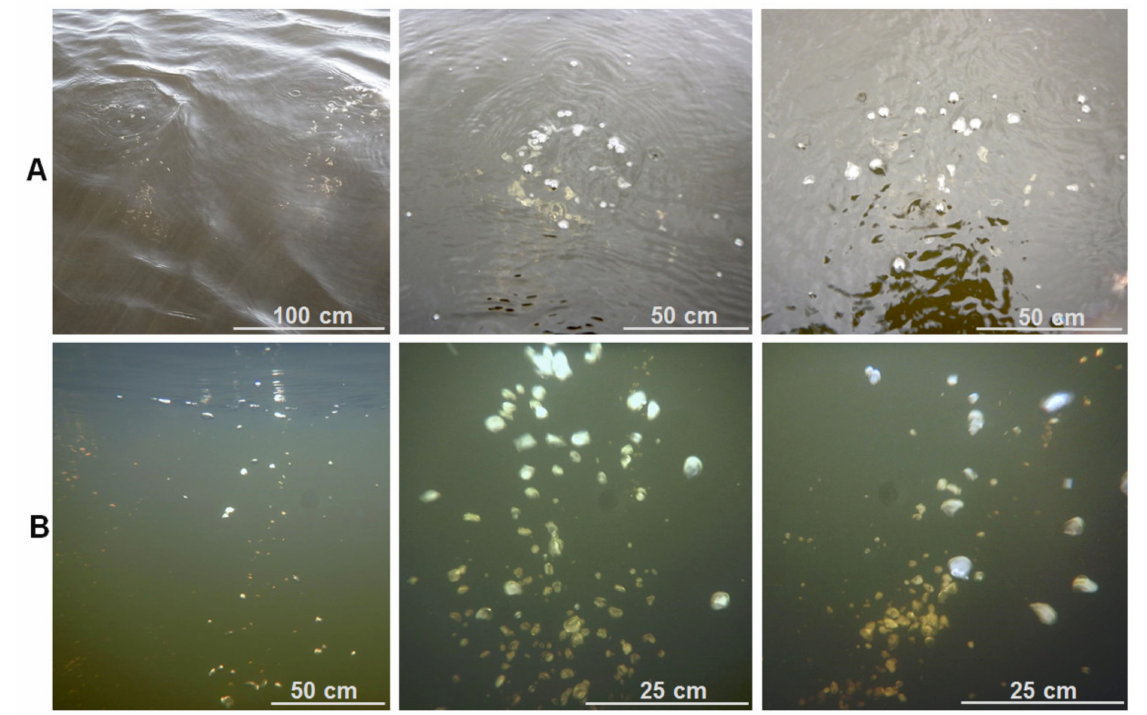
Figure 7. Typical examples of gas seeps documented via above-water ( A ) and underwater ( B ) video and photography in 2018 and 2019 (scale corresponds to the objects in the foreground).